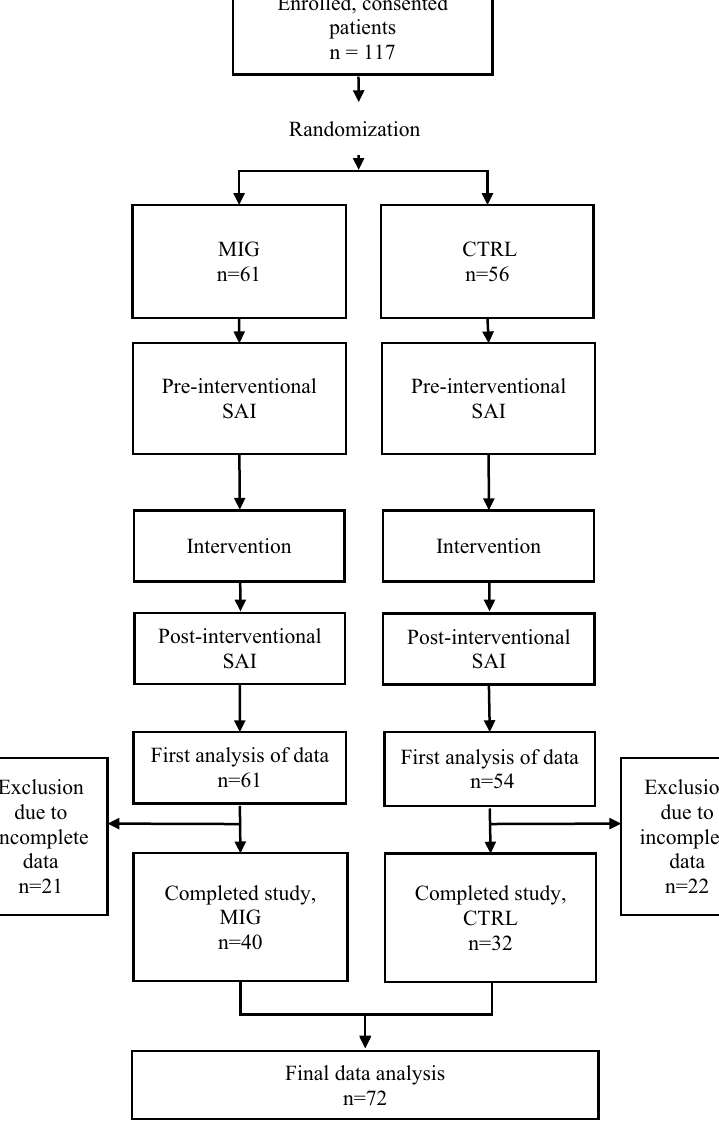
Figure 1. Study conduct from patient acquisition to statistical analysis. CTRL control group; MIG music intervention group; SAI state anxiety